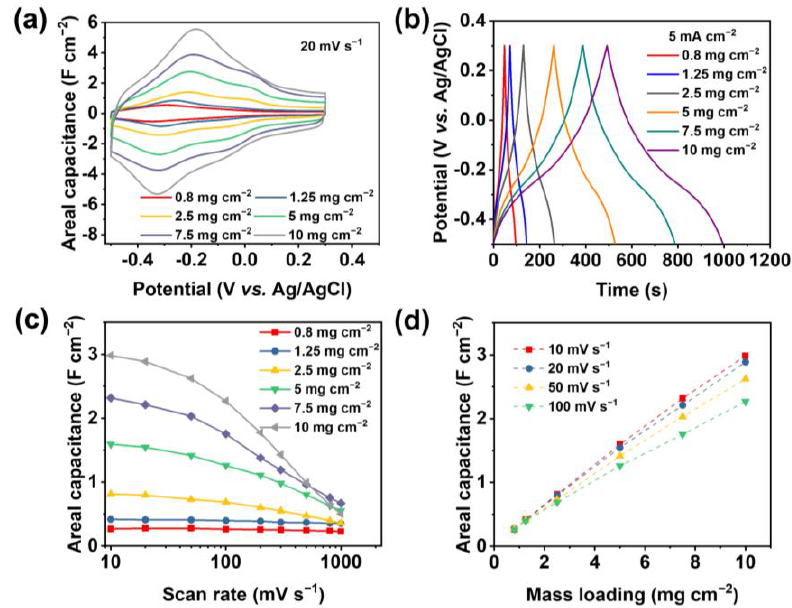
Figure 3. ( a ) CV curves at 20 mV s −1 , ( b ) GCD profiles at 5 mA cm −2 and ( c ) Areal capacitance versus scan rate from 10 to 1000 mV s −1 for aligned Ti 3 C 2 T x aerogel with mass loadings ranging from 0.8 to 10 mg cm −2 . ( d ) The relationship between areal capacitance and mass loading from 10 to 100 mV s −1 .